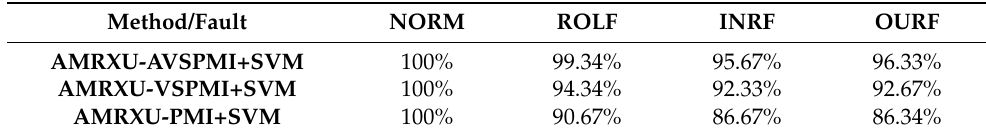
The average accuracy in fault pattern identification from the proposed AMRXU- AVSPMI+SVM compared to AMRXU-VSPMI+SVM and AMRXU-PMI+SVM.